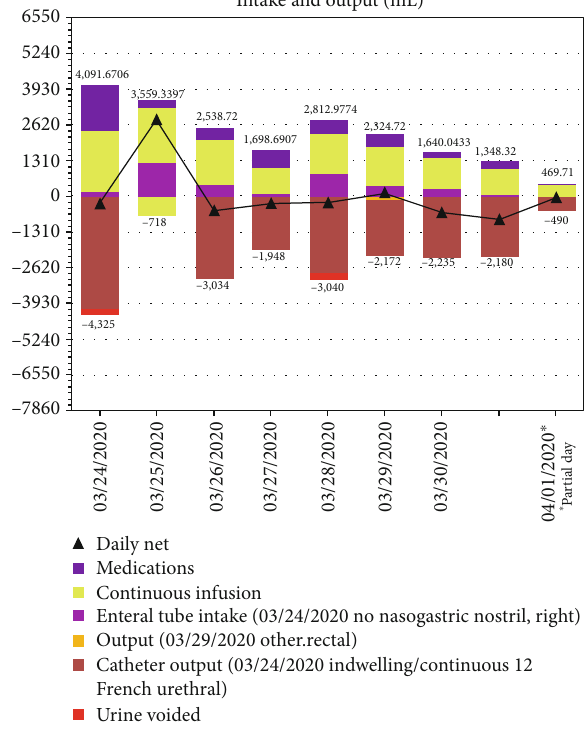
Figure 1: Overall fl uid balance for the fi rst week of PICU hospitalization as demonstrated by bar graphs of daily intake and output totals. The composition of fl uids is depicted in color. Daily net fl uid balance is depicted by triangles. Note the large net positive fl uid balance on day 2 of hospitalization (3/25) with achievement of near net balance after initiation of Furosemide on day 3